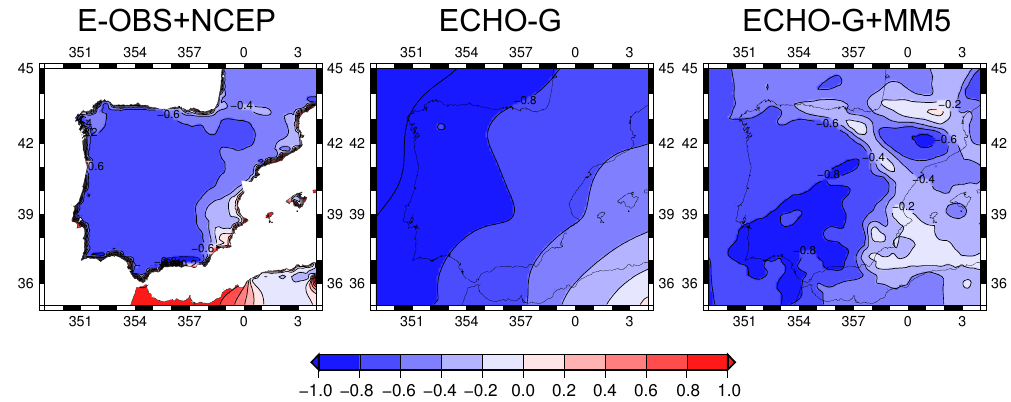
Fig. 10. Correlation maps between NAO and winter precipitation over the IP as reproduced by ECHO-G (left), ECHO-G+MM5 (centre), and a combination of reanalysis for SLP and observations for precipitation (right). The NAO index is defined in the main text.